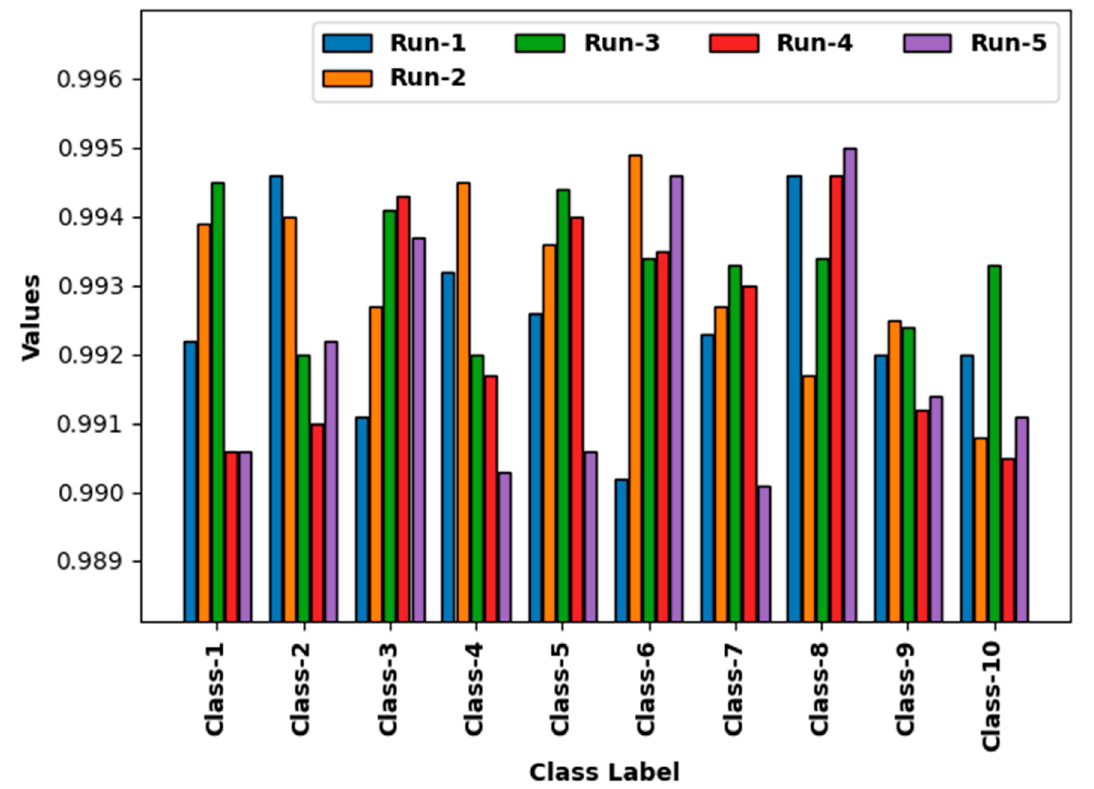
Figure 6. Accuracy analysis of SPOAI-FD technique under Bearing